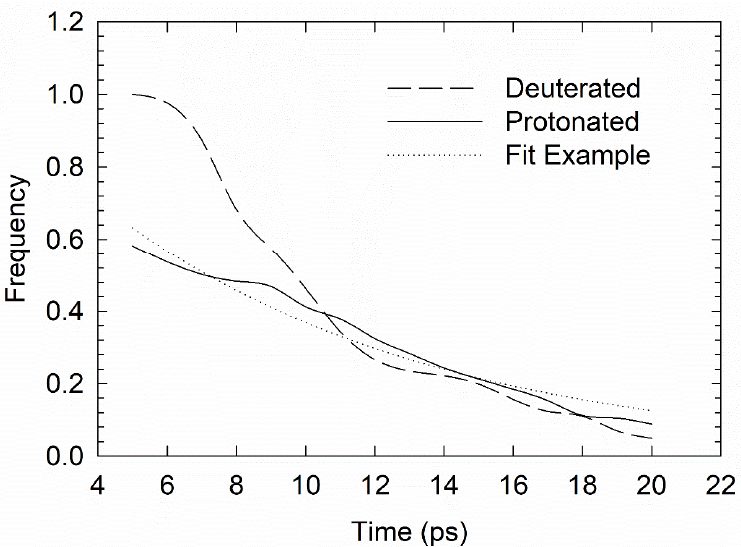
Figure 2. Decay of spatial self-correlation, as measured by deuterated-normalised histogram of tetrahedral-site dwell times, in the large-cage tetrahedral sites at 100 K from classical molecular dynamics (MD) (in arbitrary units); the double exponential decay fit is shown for the H 2 -in-H 2 O case. Table 1. τ 2 and τ 2 intra-cage site-hop relaxation times in